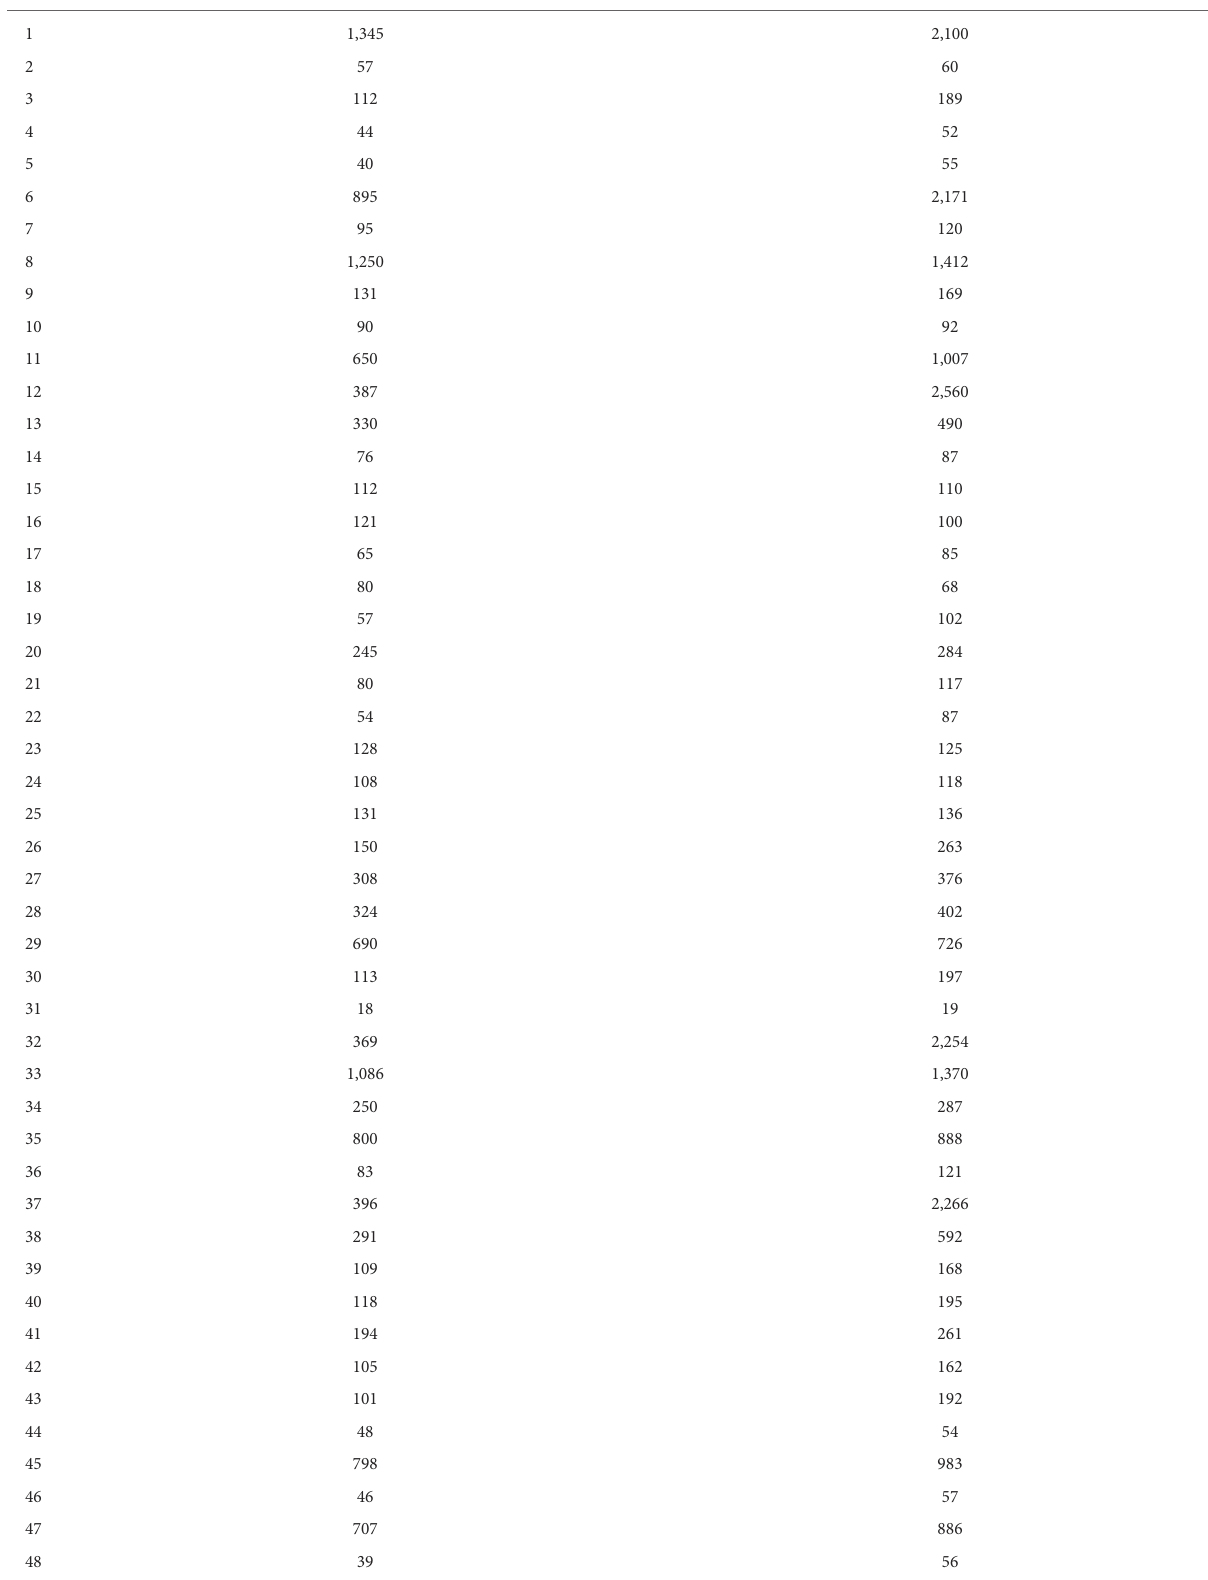
TABLE 1 Case report form vs. video